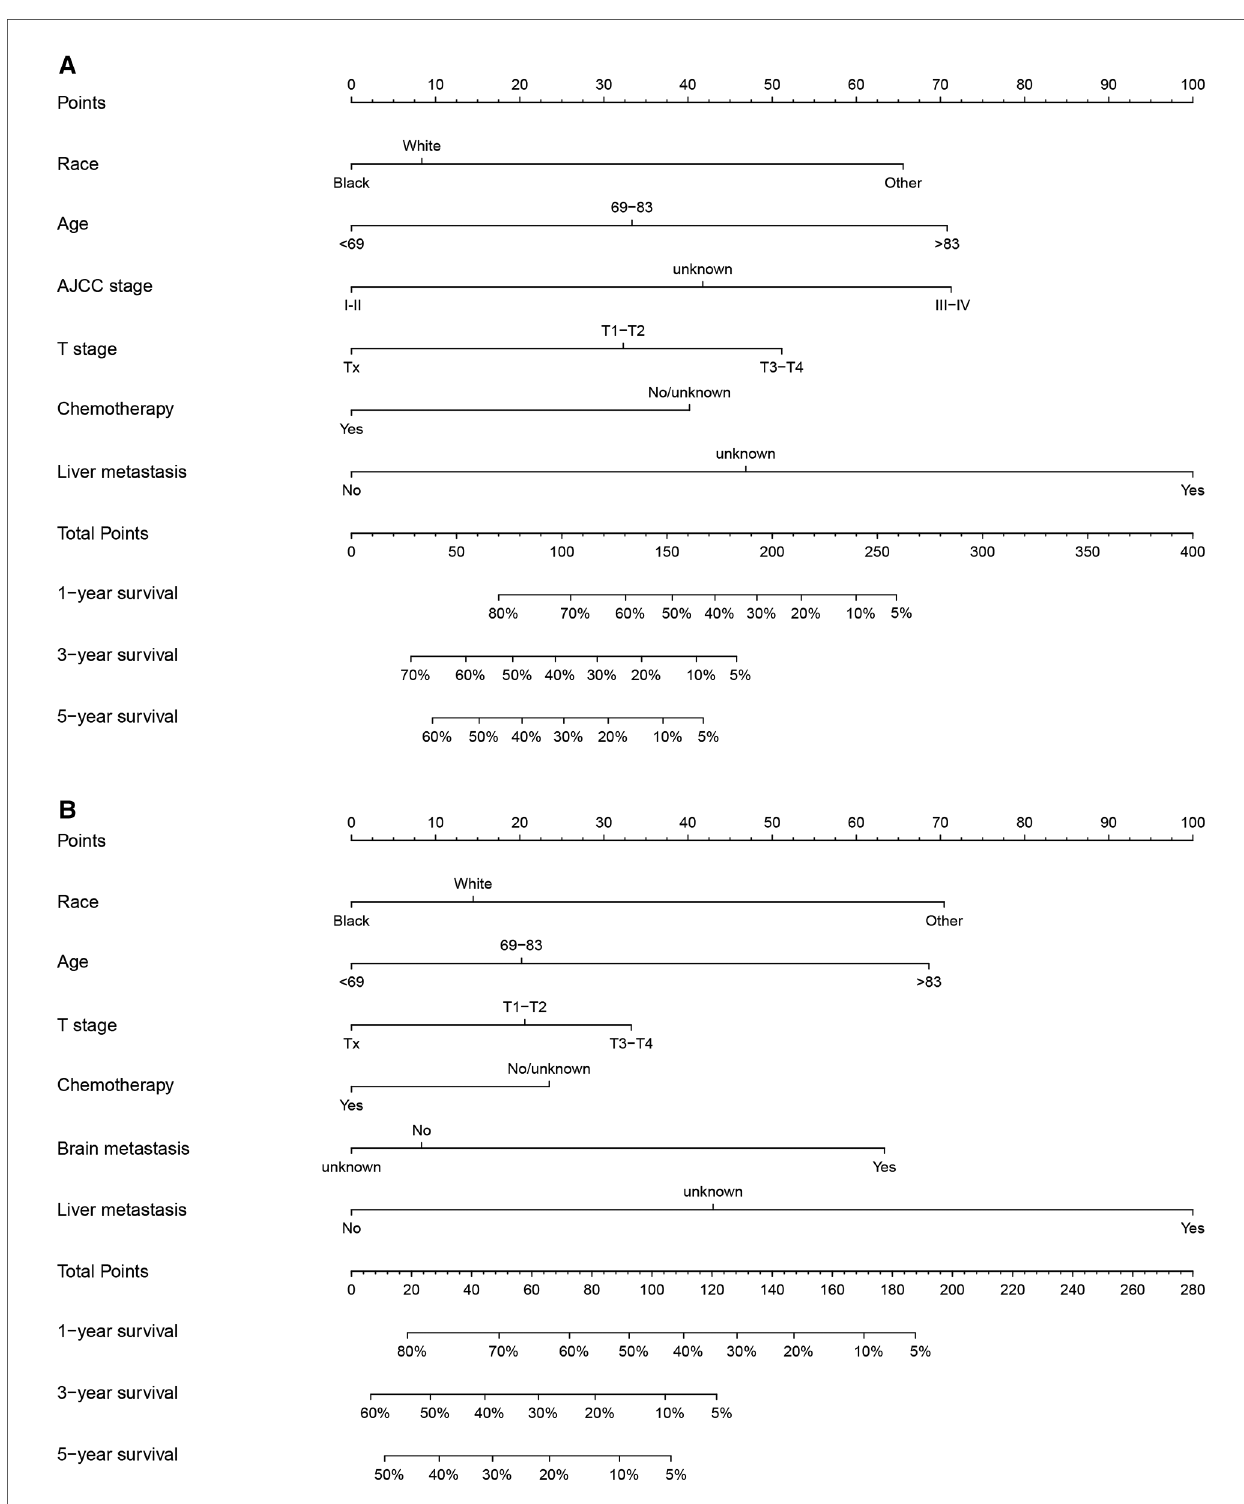
FIGURE 2 Nomograms to predict 1-, 3-, and 5-year OS or CSS of NEPC patients. ( A ) Nomogram for OS; ( B ) Nomogram for